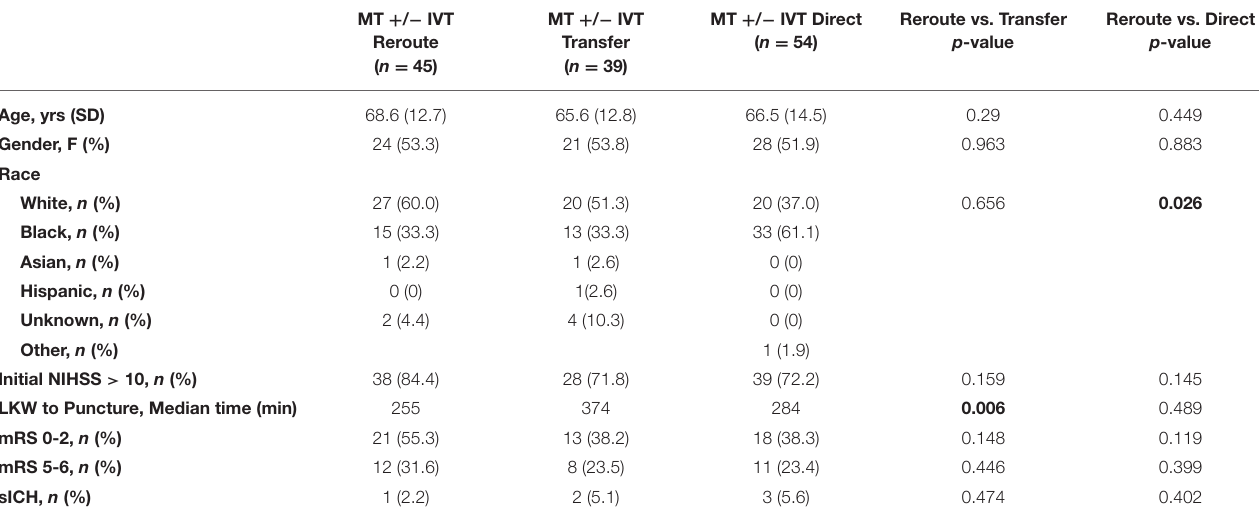
TABLE 4 | Demographics and outcomes of MT and MT + IVT by mode of arrival (reroute, transfer, or direct to ED).